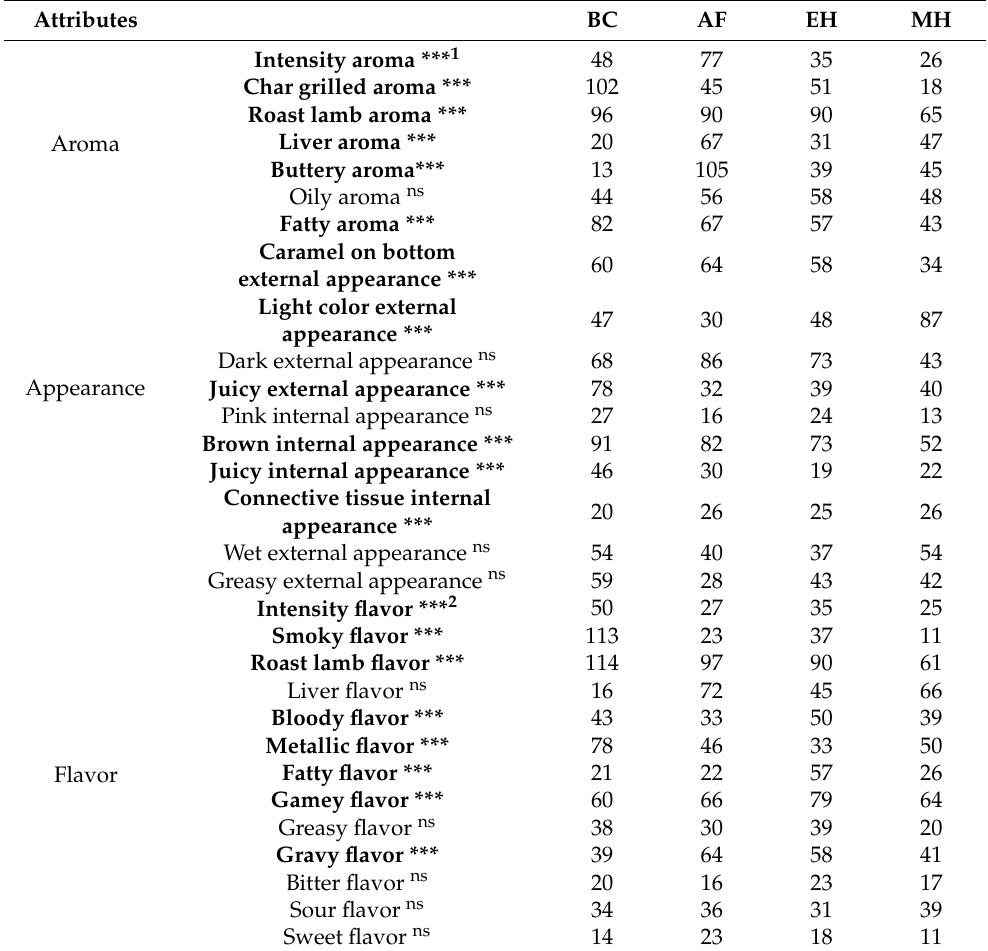
Table 1. Frequency of selection of the CATA attributes for the four samples.